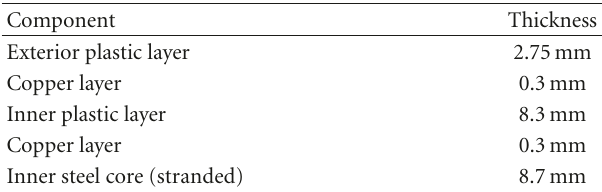
Table 1: Thickness parameters for the cable